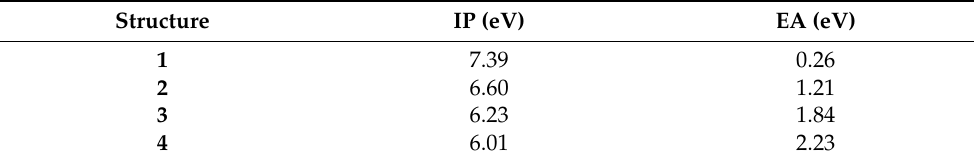
Table 1. Calculated vertical ionization potentials (IP) (eV) and electron affinities (EA) (eV) of